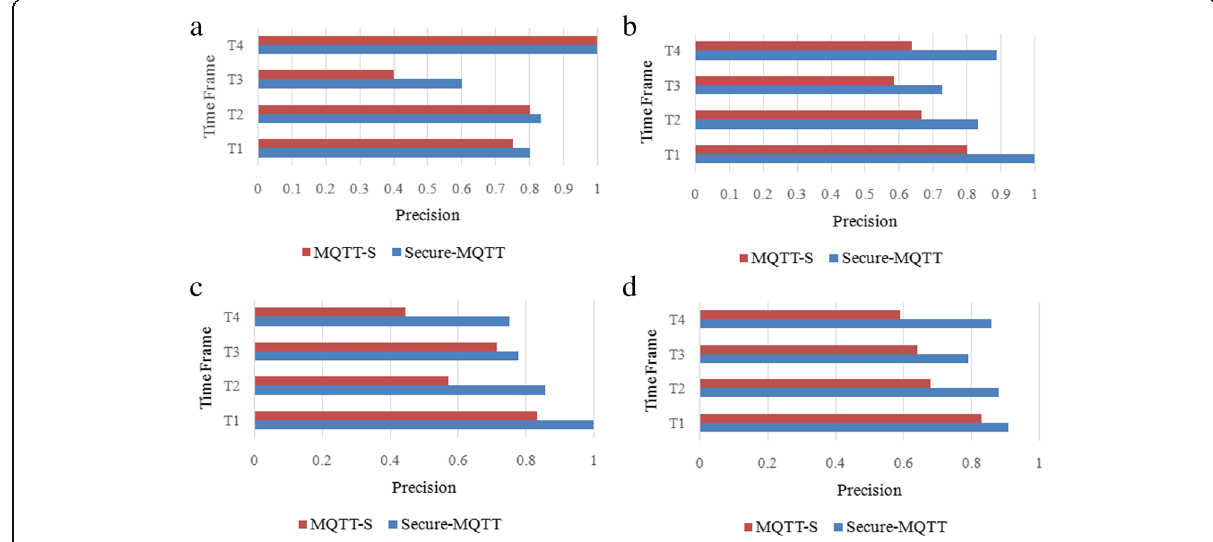
Fig. 14 a – d Precision in different time frames